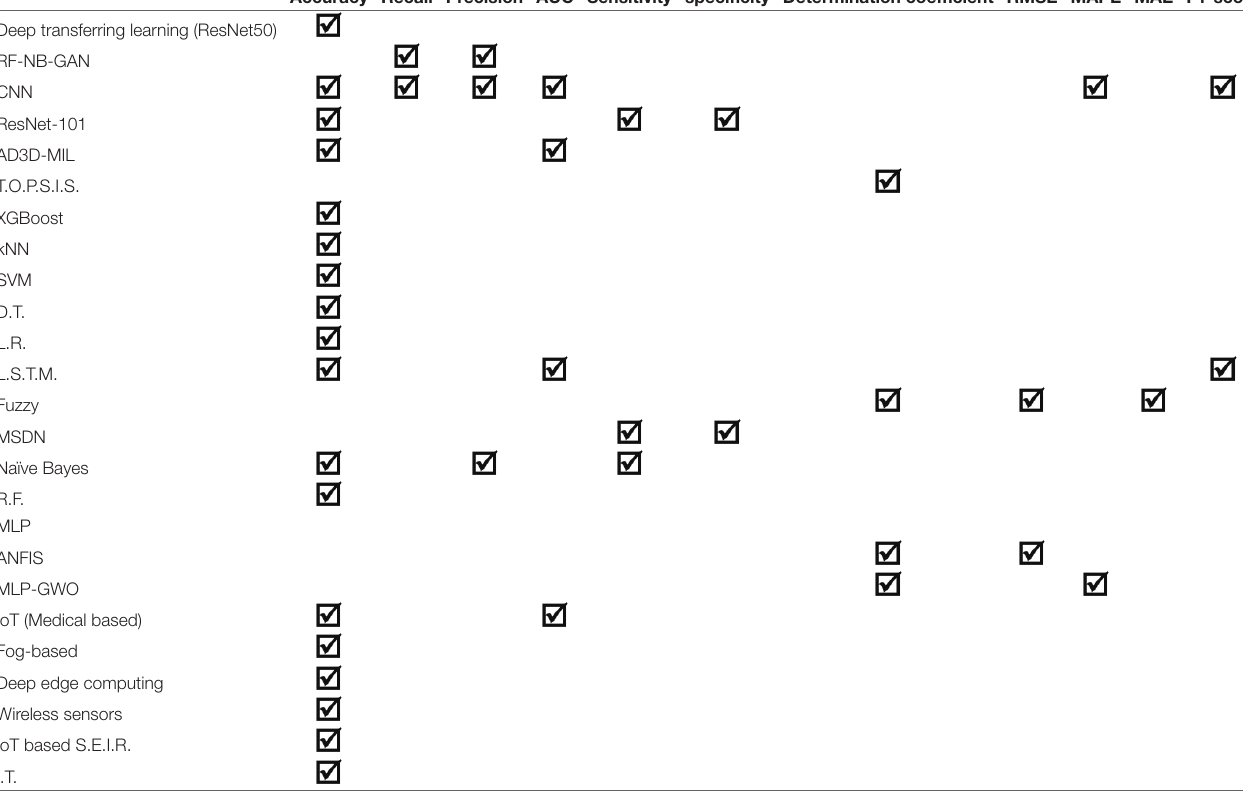
TABLE 5 | The main evaluation criteria for analyzing the performance of models.